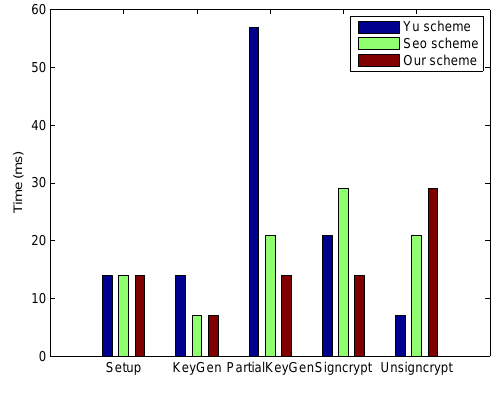
Figure 3. The experiment results.